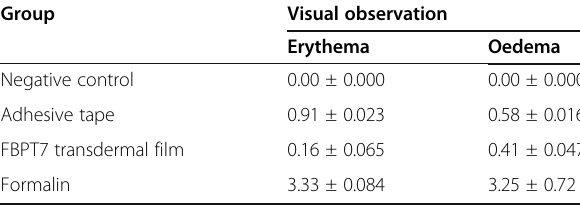
Values are expressed as mean ± S.D., n =